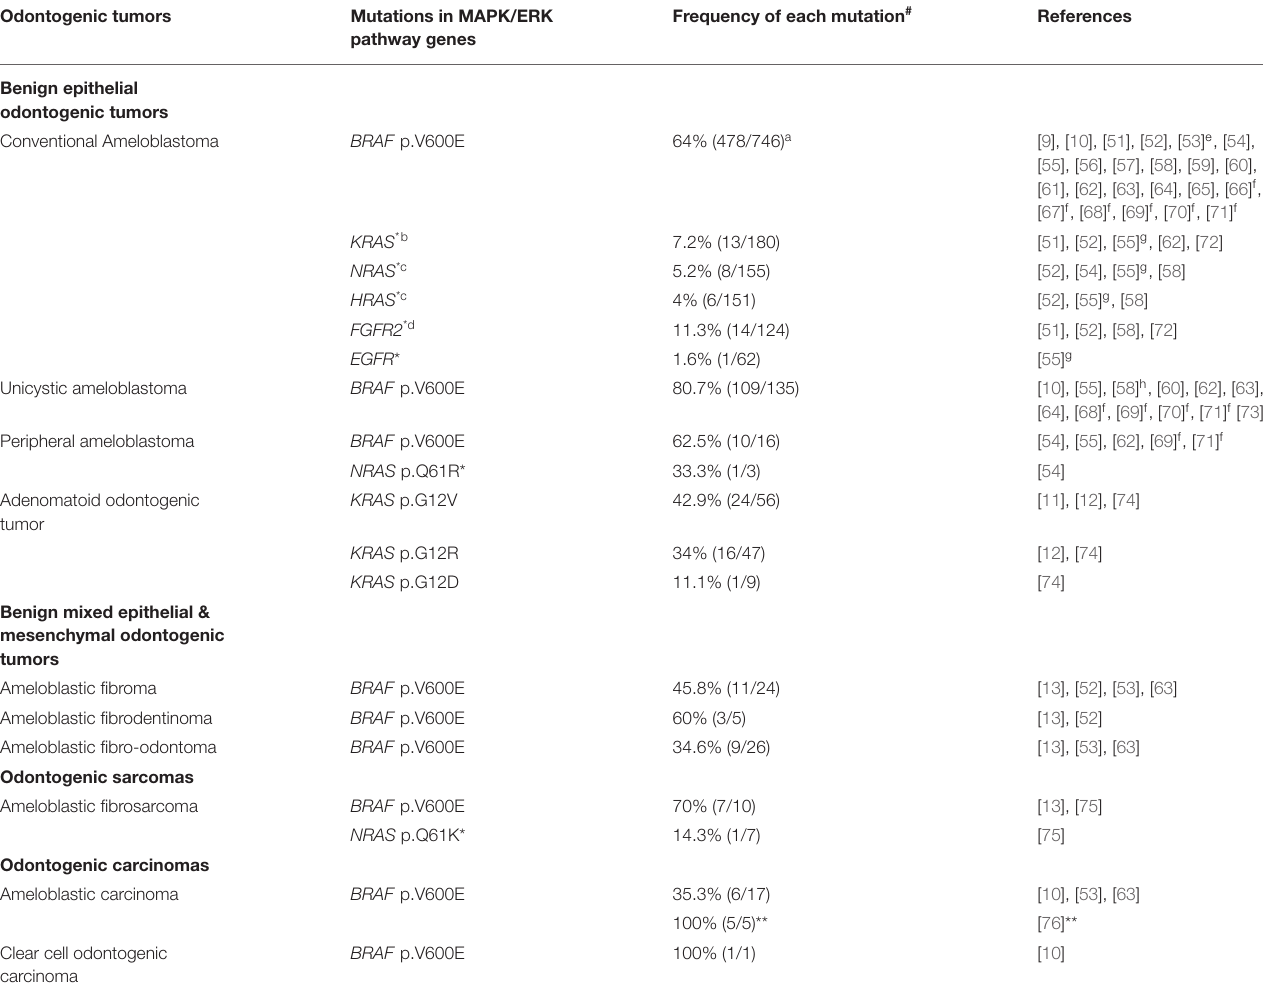
TABLE 1 | Summary of MAPK/ERK mutations and their frequencies in odontogenic